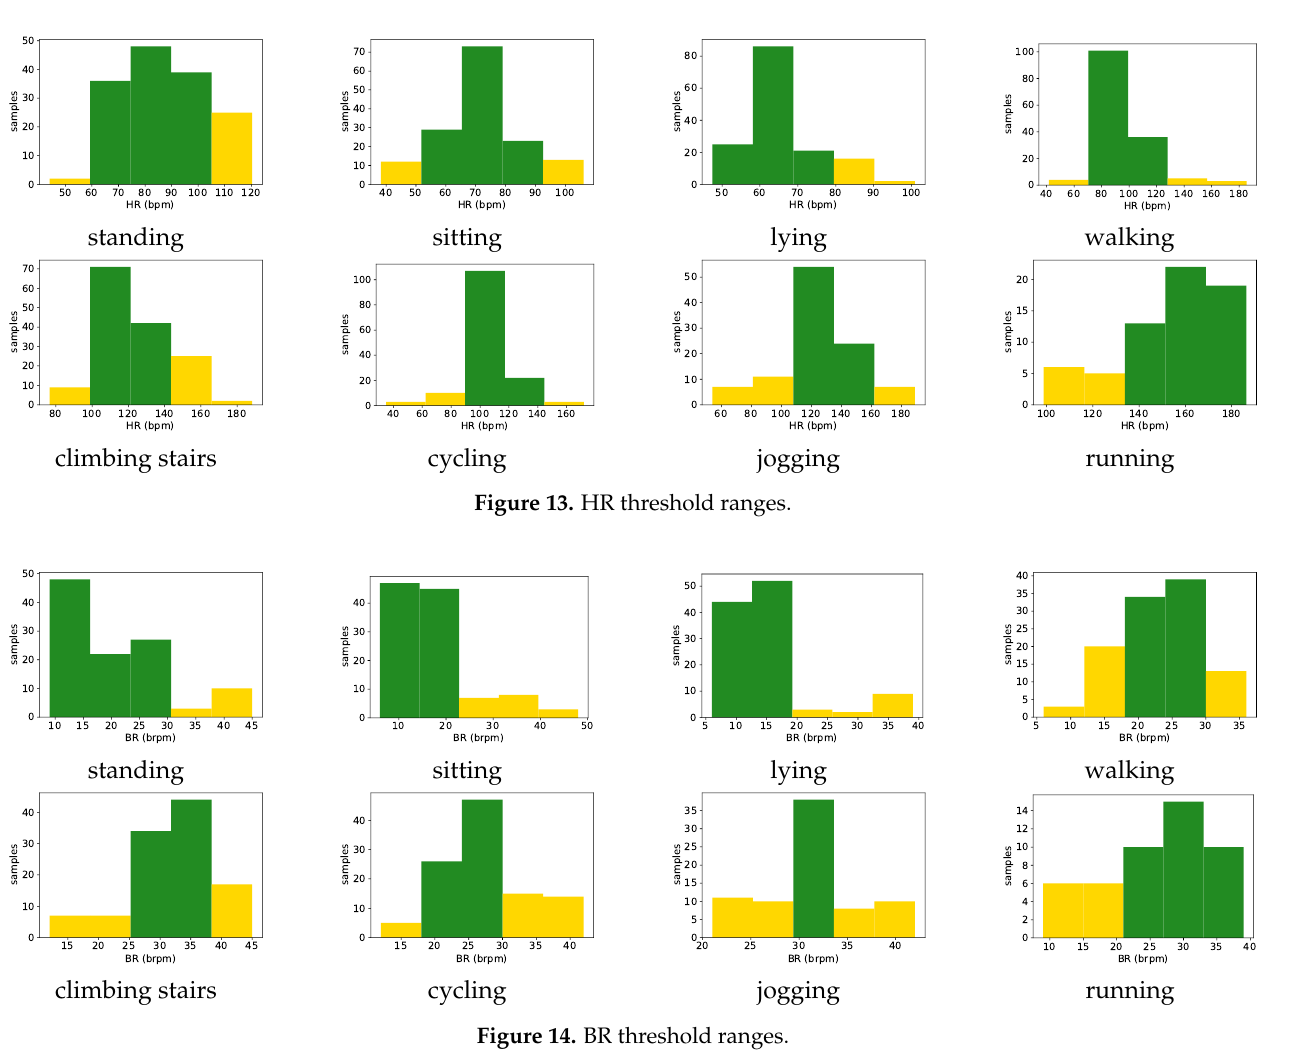
Figure 12. Extracted vital signs, HR and BR, from the ECG signal.